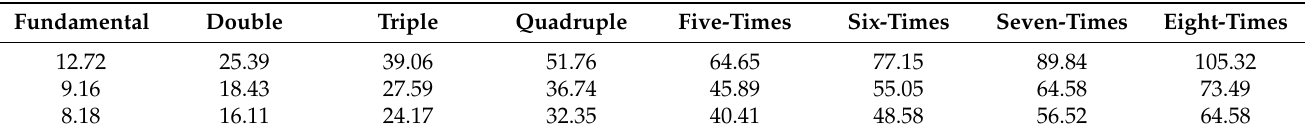
Figure 6. Power spectra of the noise recorded by the same hydrophones as in Figure 5. ( a ) The data after 18:09 UTC+8. ( b ) The data after 18:06 UTC+8. ( c ) The data after 6:00 UTC+8. The data length is 16.384 s. Table 2. The fundamental and harmonic frequencies of the three signals